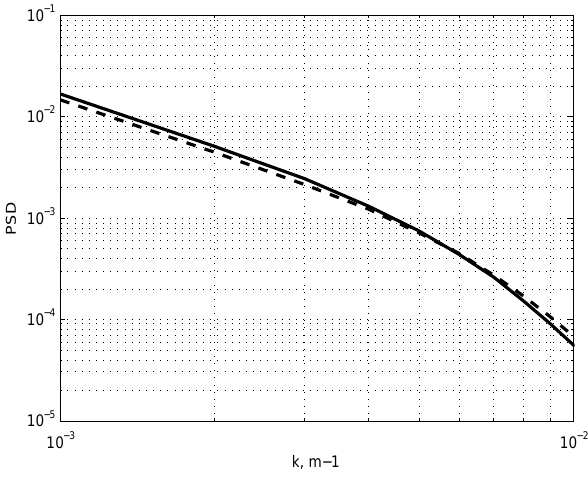
Figure 4. The power spectra of the relative Na density fluctuations calculated by Eq. (18) with N = 5 × 10 − 7 s − 1 , A = 0.216, ν = 16.6 m 2 s − 1 , and k 0 = 0.0084 m − 1 and 0.0094m − 1 (solid and dashed curves,